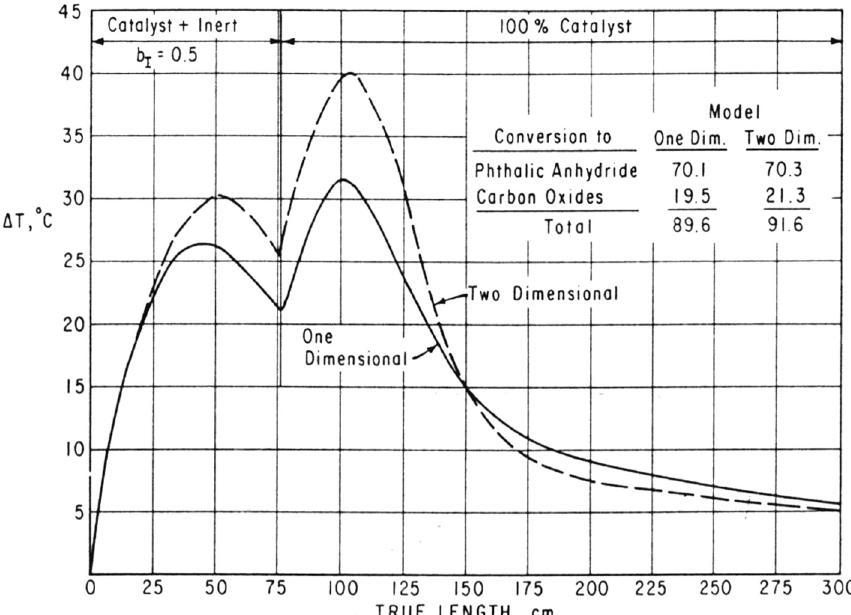
Figure 15. Comparison of the results of the one- and bi-dimensional models for reactor simulation (elaborated from data reported by Froment [33], see also [1]).